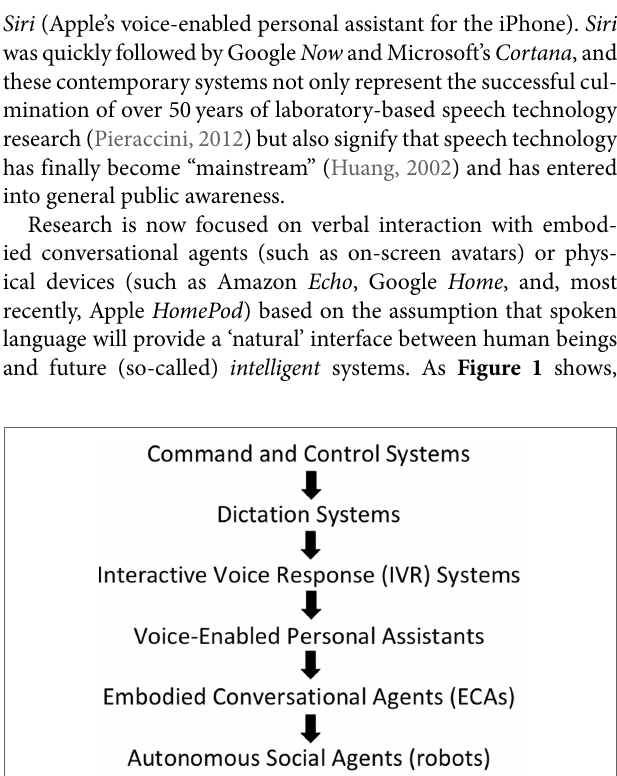
Frontiers in Robotics and AI |